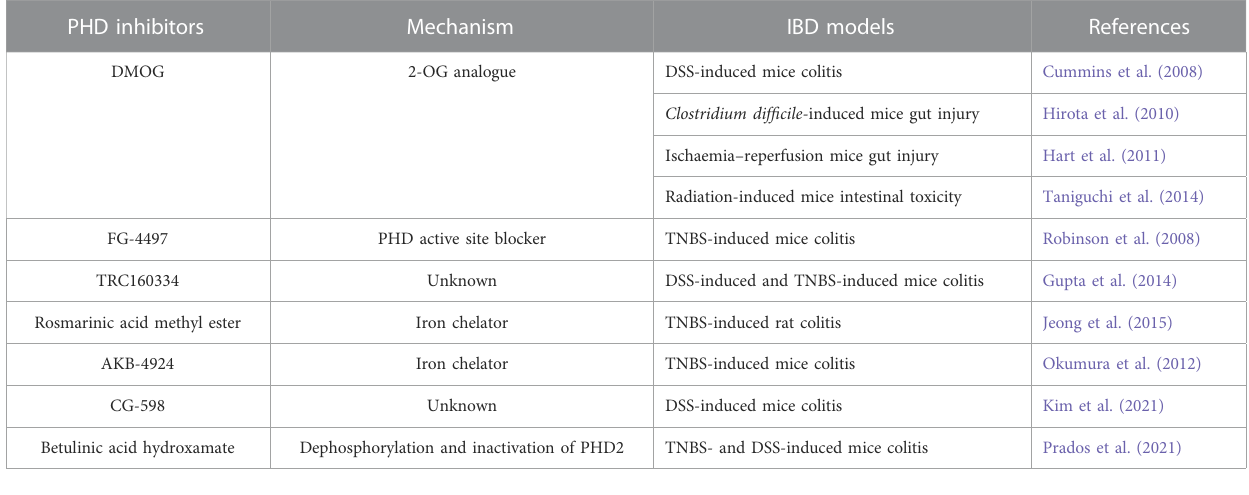
TABLE 2 PHD inhibitor GB004 in clinical trail. Clinical trail